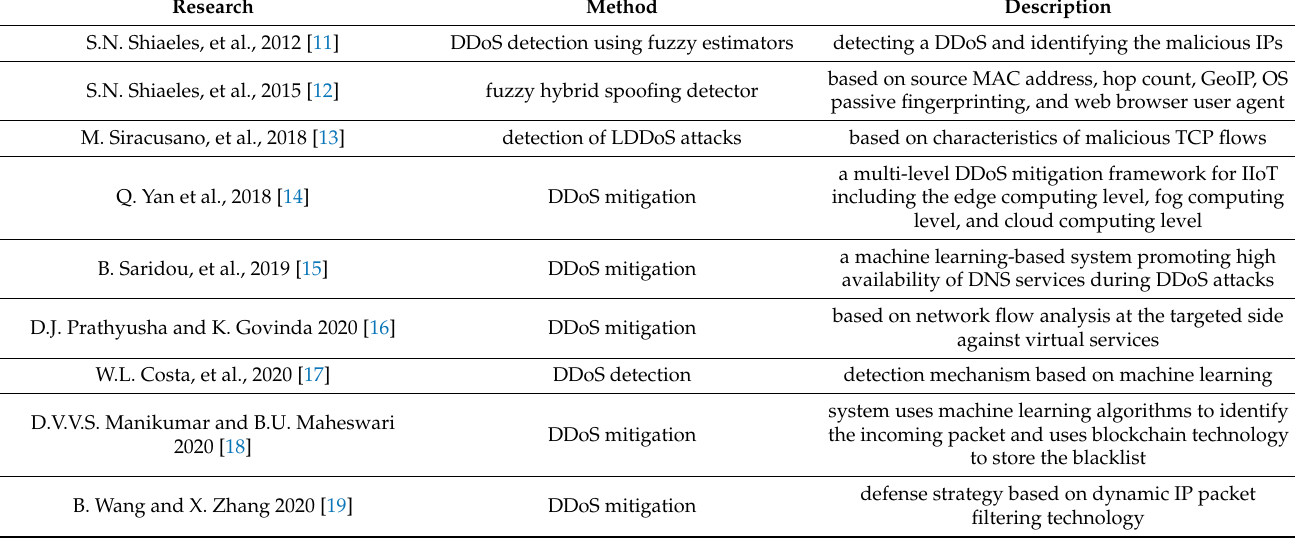
Table 1. Summary of related research for detecting, mitigating, and defending against Distributed Denial-of-Service (DDoS)